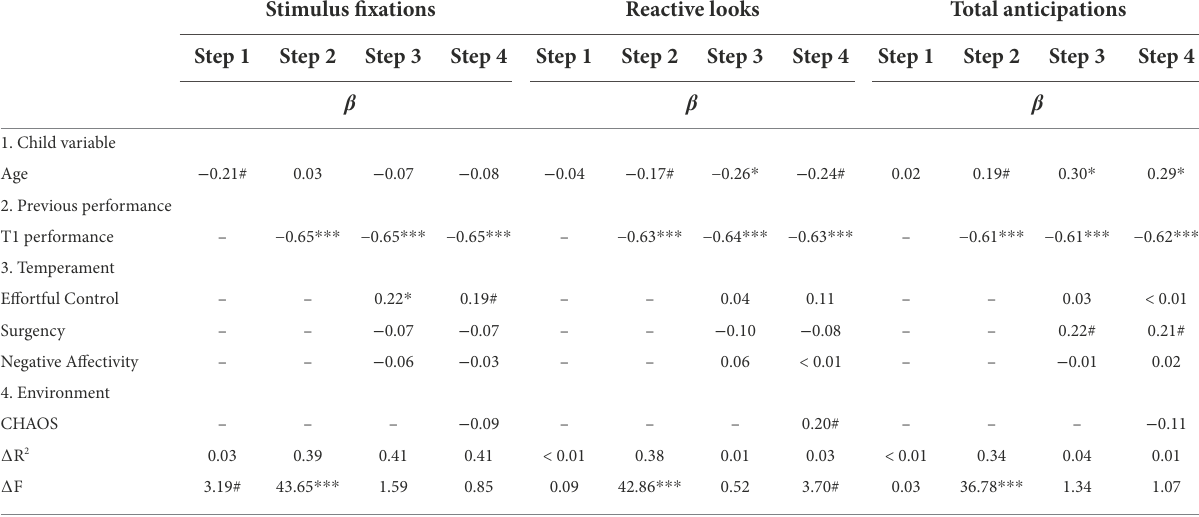
TABLE 7 Regression coefficients for change between Time 1 and Time 2 for stimulus fixations, reactive looks, and total